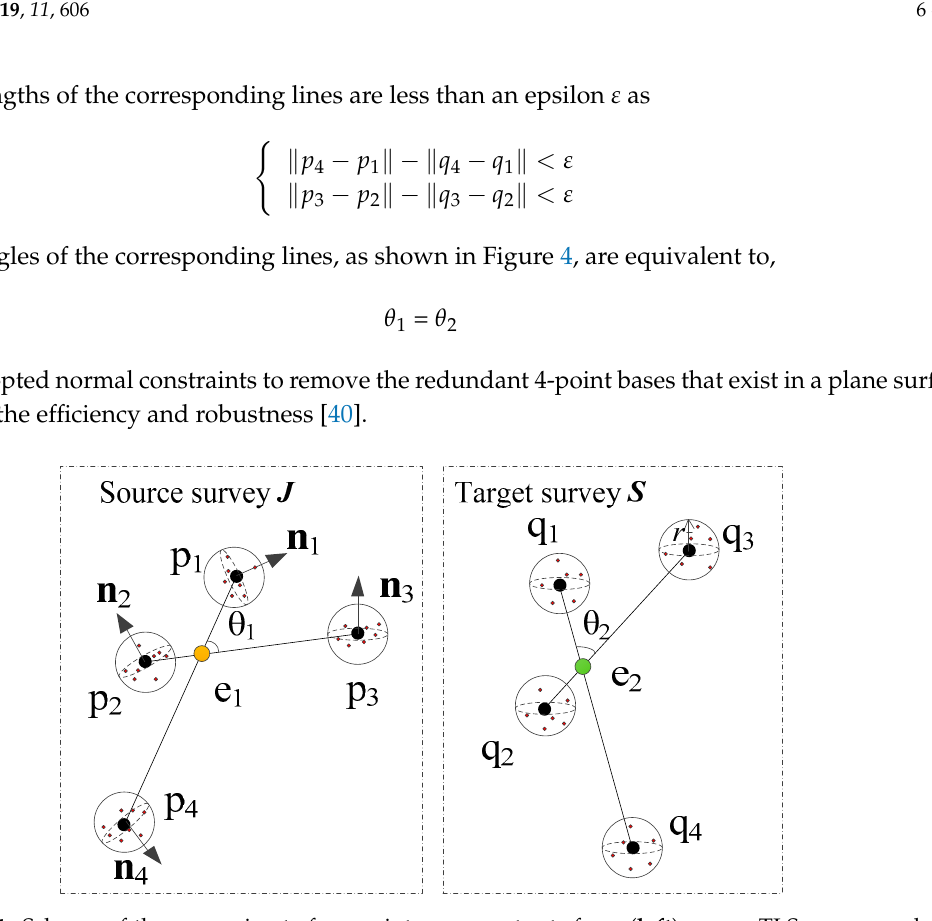
Figure 4. Scheme of the approximate four-point congruent sets from ( left ) source TLS survey and ( right ) target TLS